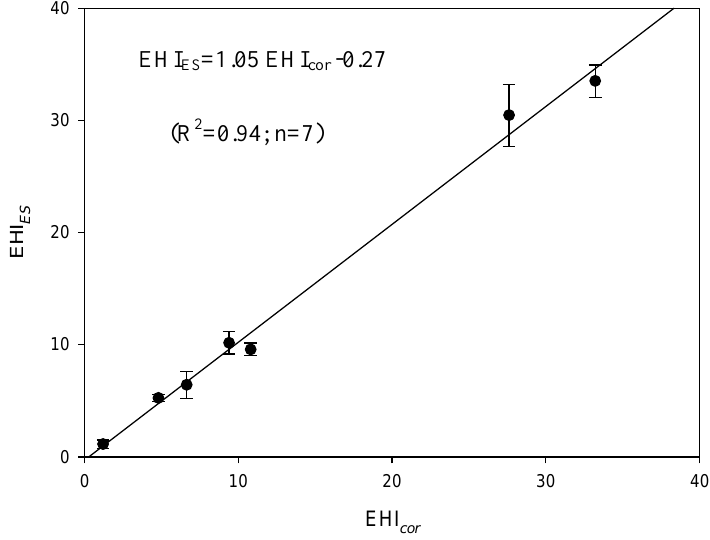
Figure 4. The relationship between EHI corresponding corrected EHI (EHI